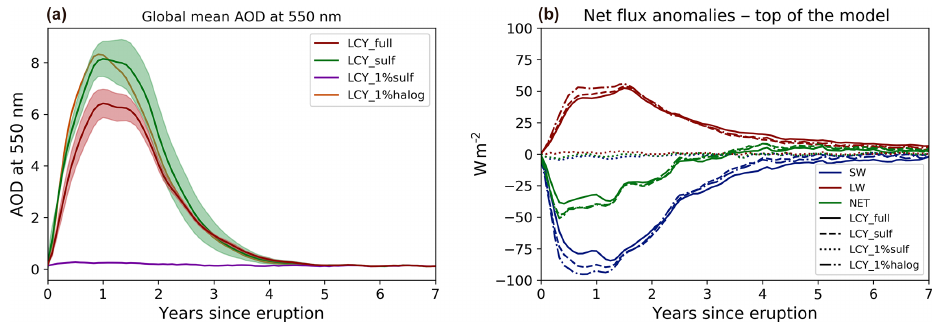
Figure 2. Total aerosol optical depth (AOD) at 550nm and net radiative flux anomalies at the top of the model in the four LCY eruption